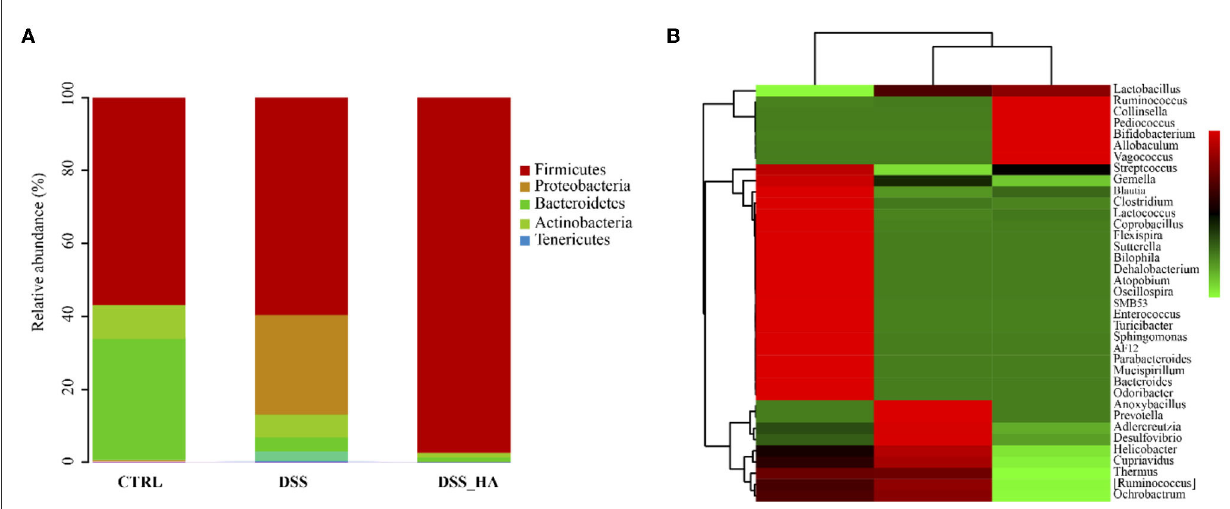
FIGURE3 HAs alter the bacterial community of the gut in mice. (A) Taxonomic composition of the microbiota in the CTRL, DSS, and DSS_HA groups at the phylum level. (B) Heatmap of the top 50 dominant genera in each group.